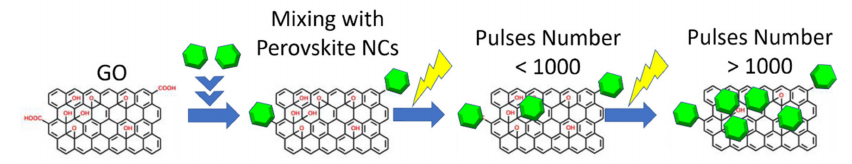
Figure 5. Proposed mechanism of the anchoring of metal nanocrystals on the GO